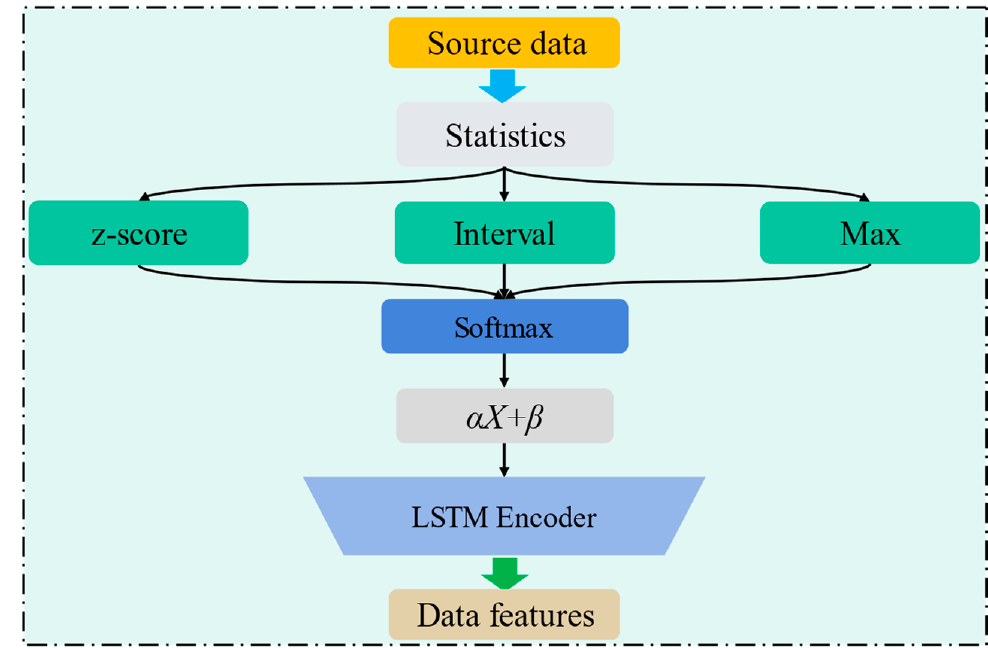
Figure 2. Flow chart of the combined normalized encoder with three normalization methods. Each of the three normalizations has its strengths and can process the input data to the standard normal distribution, ( a , b ) specific interval, and between ( − 1, 1), respectively, to exert different effects on the data. Among them, z-score [27] processing can obtain data con- forming to the standard normal distribution and reduce data distribution differences [31]; Interval method [25] processing fixes the results in a specific interval to prevent gradient disappearance and gradient explosion problems; Max [28] is scaling normalization scales down the input data without changing the scale characteristics of the input data. In order to use the effect of the three normalization methods on the input data, this paper uses the adaptive combined normalization method to weigh the calculation results of normalization and determine the most suitable normalization calculation method. In the combined normalization layer, the Softmax function [29] acts as a combined function and is calculated as follows: